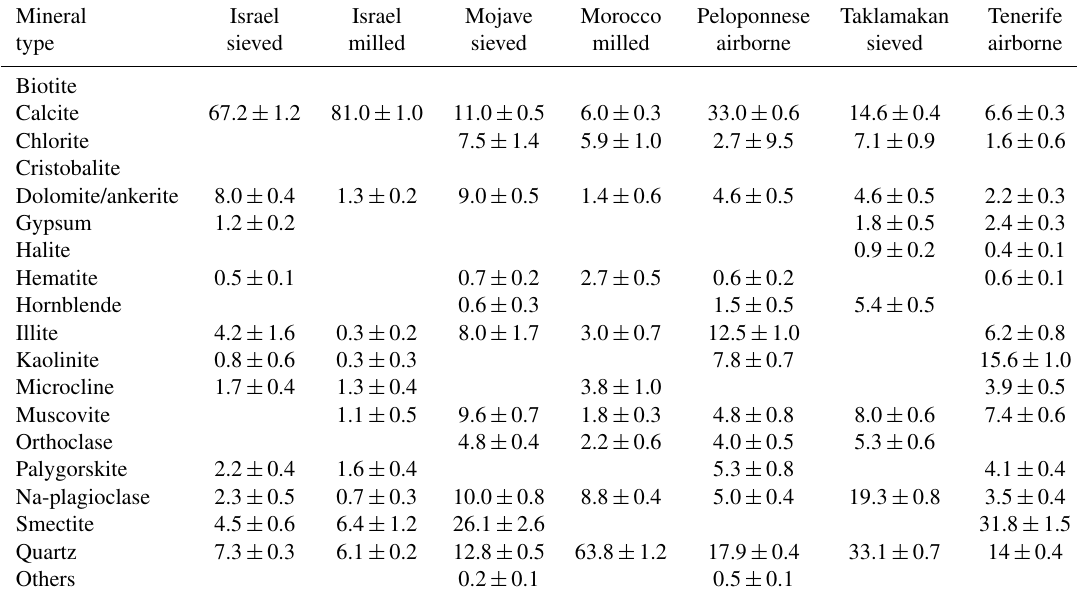
Table 3. Mineralogical composition in wt% and uncertainty from the Rietveld refinement using AutoQuan continued. Where microcline and orthoclase are present in the same sample, their individual fraction could not be